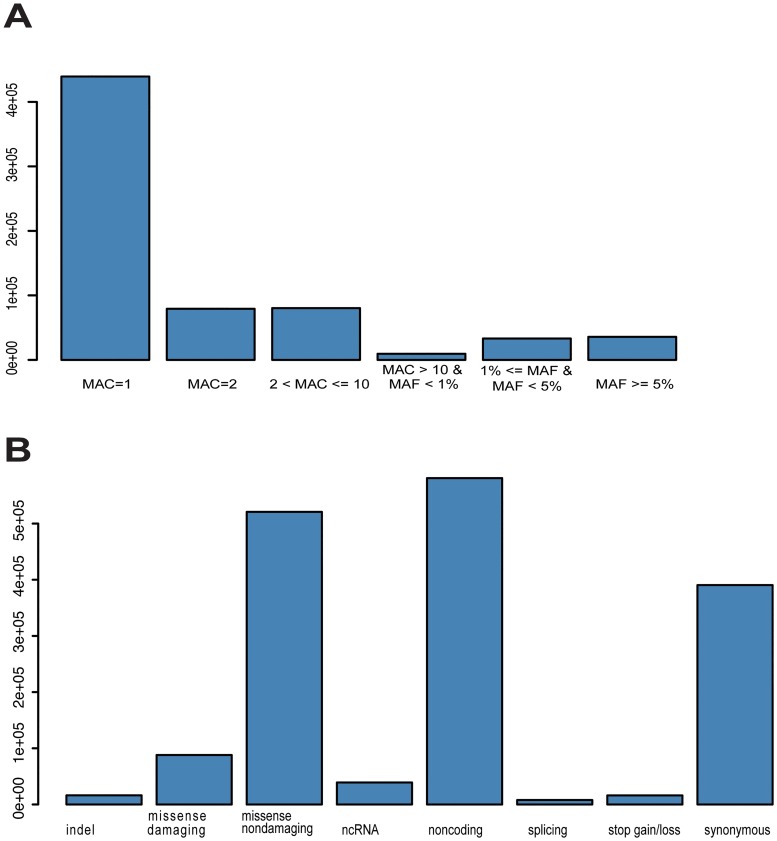
Single variant analysis.Single variants included in primarily analysis by frequency (panel A) and type (panel B).